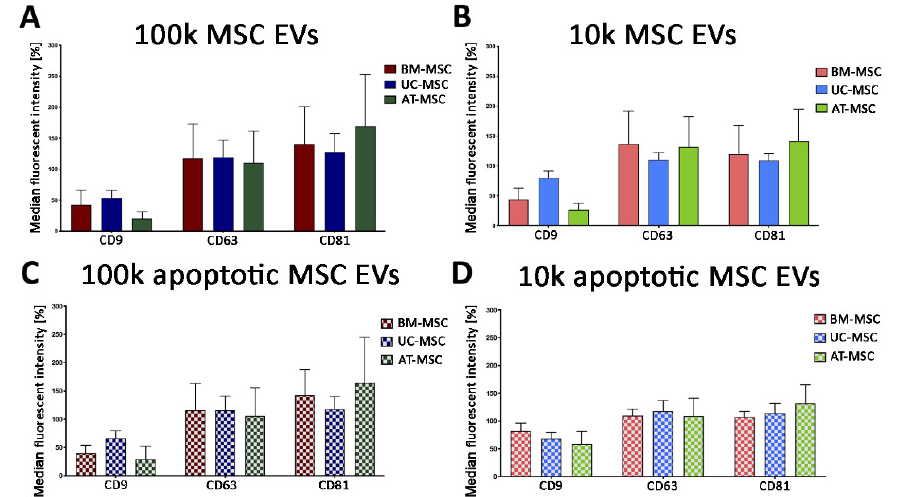
Figure 6. MACSPlex tetraspanin analysis of 100k MSC EVs and 10k MSC EVs of naive and apoptotic MSCs. Histograms represent the median fluorescence intensity of CD9, CD63 and CD81 tetraspanins for 100k MSC EVs ( A , C ) and 10k MSC EVs ( B , D ) isolated from naive ( A , B ) and apoptotic ( C , D ) MSCs. BM-MSC EVs, UC-MSC EVs and AT-MSC EVs were compared. Data are expressed as mean ± SD of three different experiments.